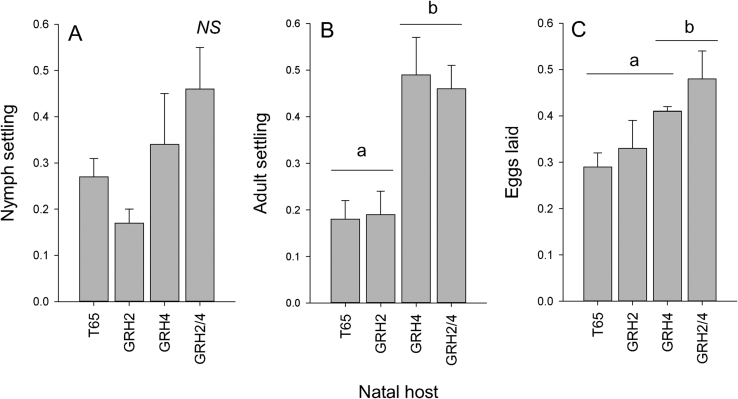
Proportion of nymphs (A) and adults (B) settling on GRH2/GRH4-PYL in choice bioassays, with (C) eggs laid on GRH2/GRH4-PYL as a proportion of the total number of eggs laid in the bioassays (i.e., eggs on PYL/(eggs on PYL + eggs on T65)). Bioassays were conducted with colonies selected on T65, GRH2-NIL, GRH4-NIL or GRH2/GRH4-PYL (indicated as ‘T65″, ‘GRH2″, ‘GRH4’ and ‘GRH2/4’, respectively on the x-axes) for 20 generations. Lowercase letters indicate homogenous groups (Tukey tests, P ≤ 0.05); standard errors are indicated (N = 5 colonies).